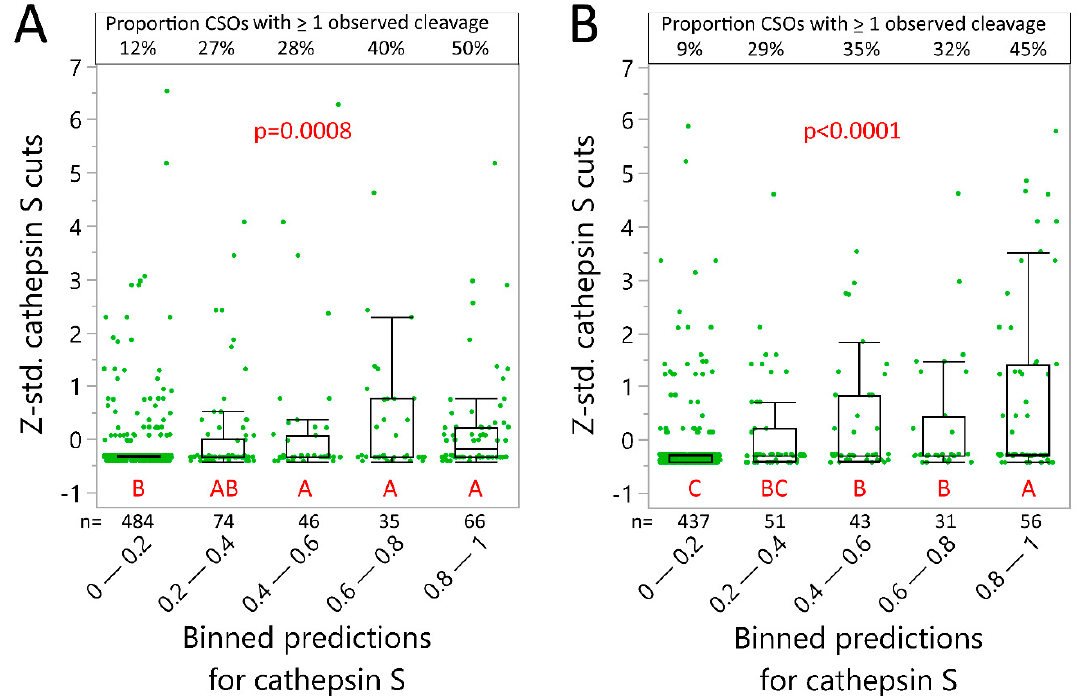
Figure 6. Evaluation of cleavage accuracy for monoclonal antibody variable regions. Cleavage probability by cathepsin S for all possible cleavage site octamers (CSOs) within ( A ) heavy and ( B ) light chain variable regions of rituximab, infliximab, ocrelizumab, natalizumab, alemtuzumab, and adalimumab were binned into ranges of 0.2 (X-axis). Intra-chain z-standardized number of observed cuts after 24 h at pH 6 are depicted on the Y-axis. p -values indicate Welch ANOVA significance (F(4, 5.16 / 9.05) for heavy and light respectively), and differing red letters indicate significant differences between groups (Tukey–Kramer, HSD). Whiskers are outlier box-plots.